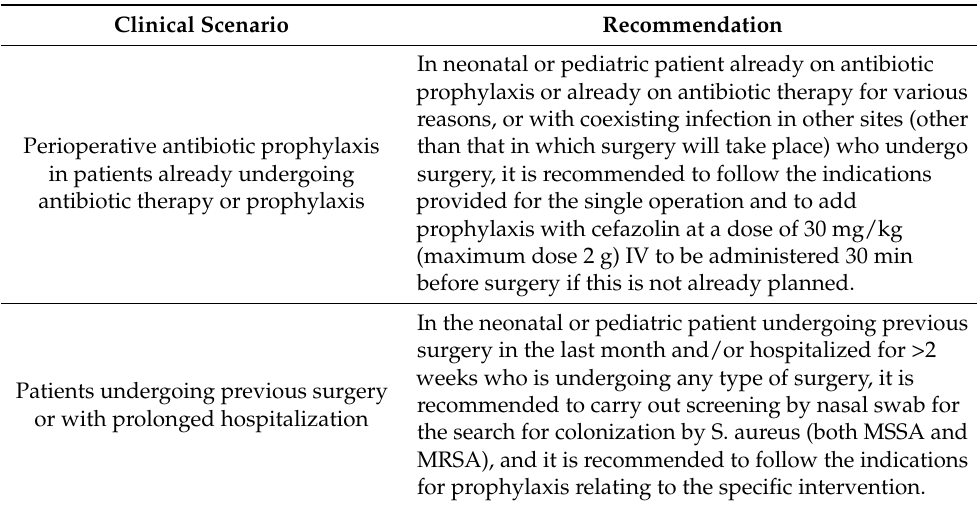
Table 1. Cont . Clinical Scenario Recommendation